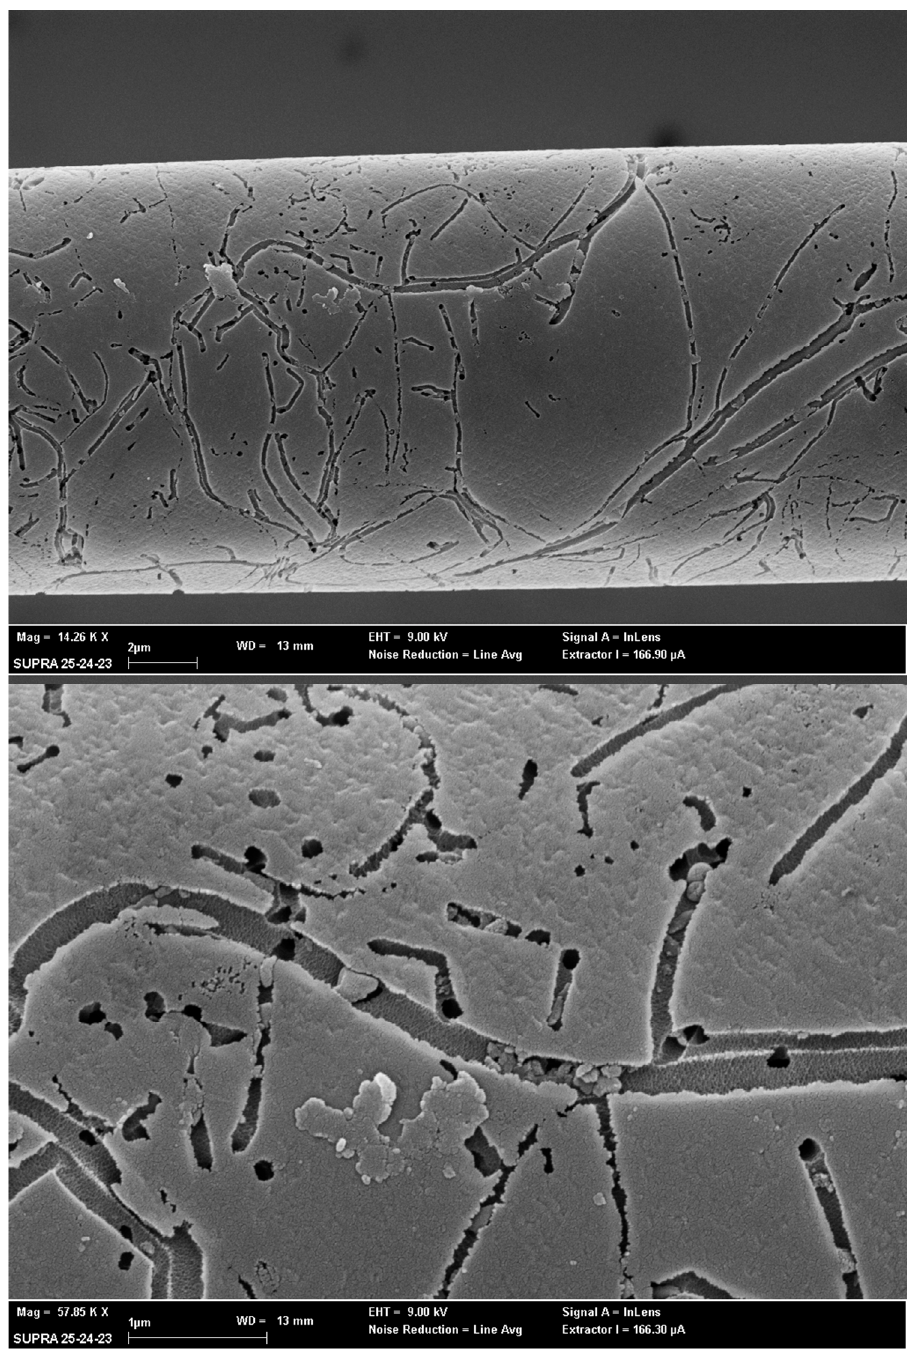
Figure 6. APCF morphological analysis with a magnification range between 1 and 58